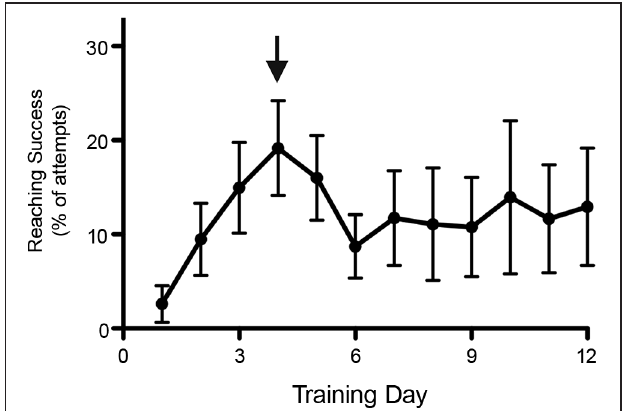
FIGURE 2 | Decreased performance in behavioral tests by rats in the vicinity of stress. Reaching performance dropped substantially when a second (independent) group of rats housed in the same room underwent surgery (as indicated by the arrow), an intus cella effect. Reaching performance remained low for over a week. Data is shown as mean ± SEM, n =